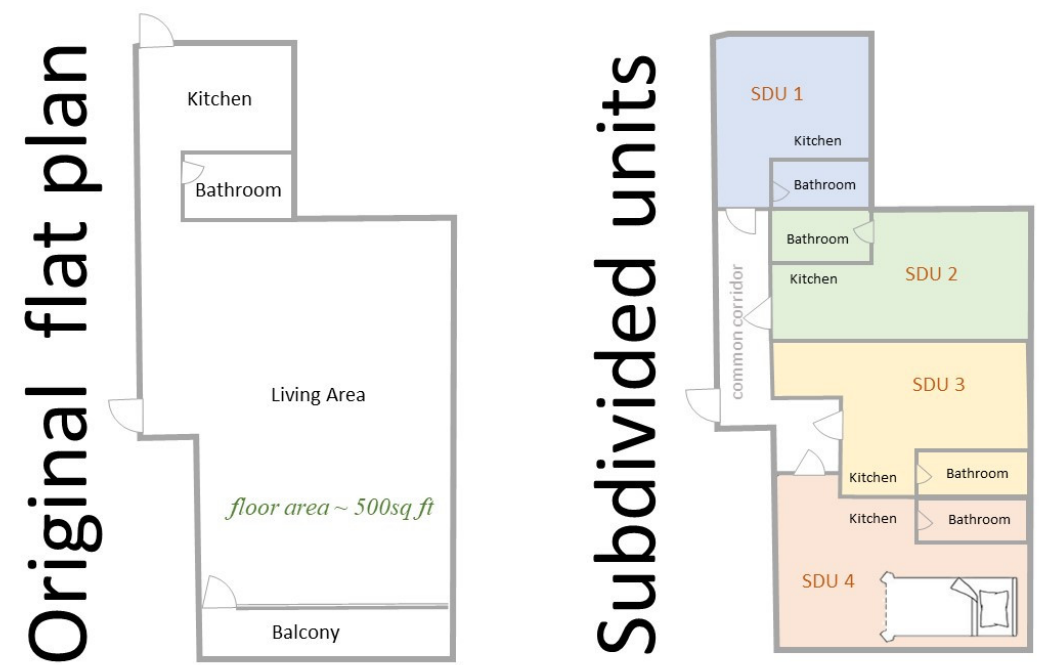
Figure 1. Schematic diagram of an SDU in contrast to the original flat layout.